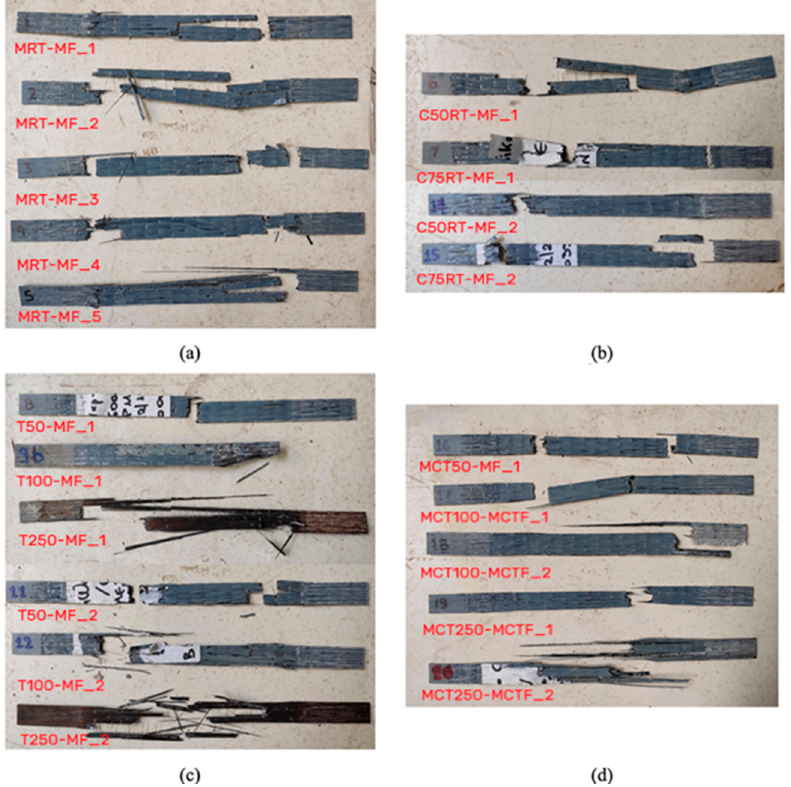
Figure 21. Specimens after their failure: ( a , b ) experiments at room temperature; ( c , d ) experiments at elevated temperatures.